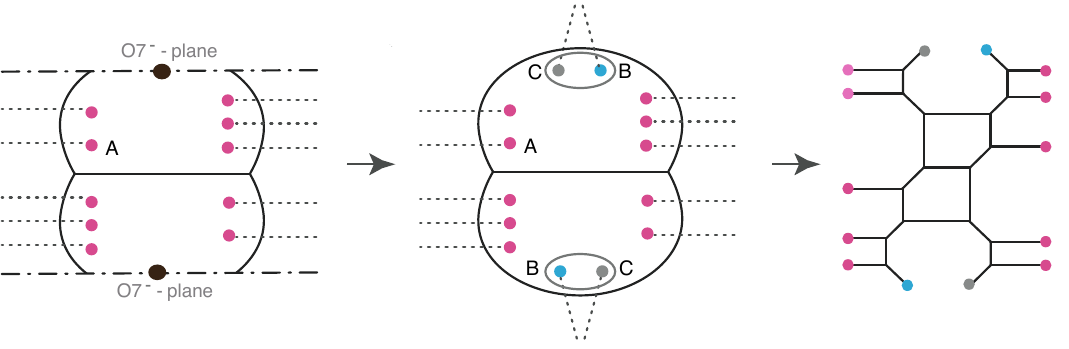
Figure 2 . Type IIB brane descriptions for 6d = (1 ; 0) Sp( N ) gauge theory with one tensor N multiplet and 2 N + 8 (cid:13)avors in the fundamental representation, which yields = 1 SU( N + 2) N gauge theory with the number of (cid:13)avors. The horizontal direction is x 6 and the vertical direction is the T-dualized direction. For simplicity, N = 1. Left: the brane con(cid:12)guration with two O 7 (cid:0) planes. A dashed line denotes the branch cut of 7-brane, while a dash-dot line denotes the mirror re(cid:13)ection cut of an O 7 (cid:0) plane. Middle: the brane con(cid:12)guration with two O 7 (cid:0) planes which are non-perturbatively resolved. Here we denote A for a D7 brane, B for a [1 ; 1] 7-brane, and C for a (cid:0) [1 ; 1] 7-brane. Right: pulling out 7-branes gives rise to a web con(cid:12)guration for SU(3) gauge theory with N f = 10 (cid:13)avors and zero CS